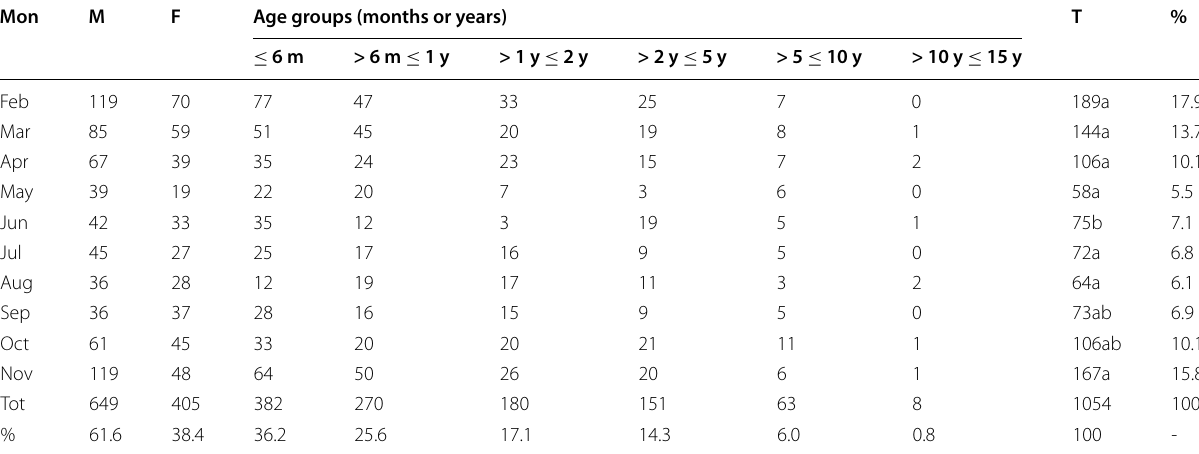
M for male and F for female, T for total children, m for month and y for year. Total counts for the months followed by the same small letter in column are not significantly different (Tukey’s HSD, p =